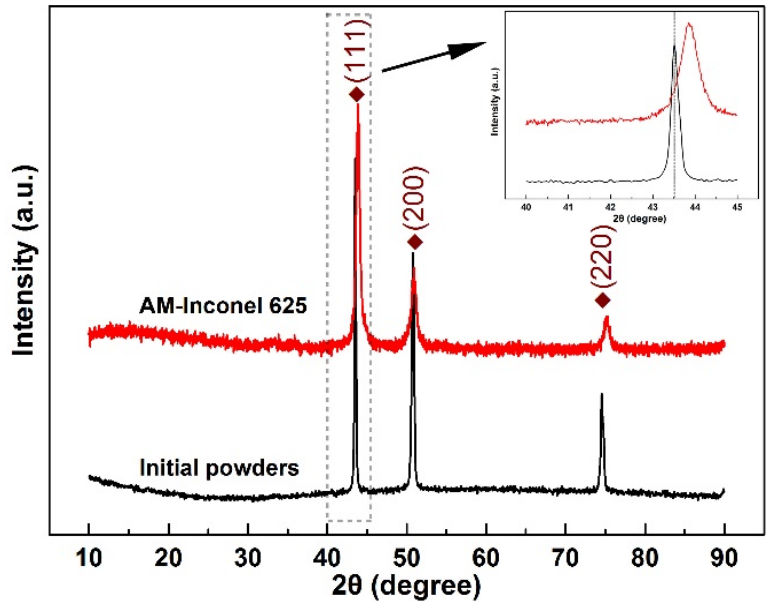
Figure 3. XRD results of the as-received initial Inconel 625 powders and specimen after AM process.